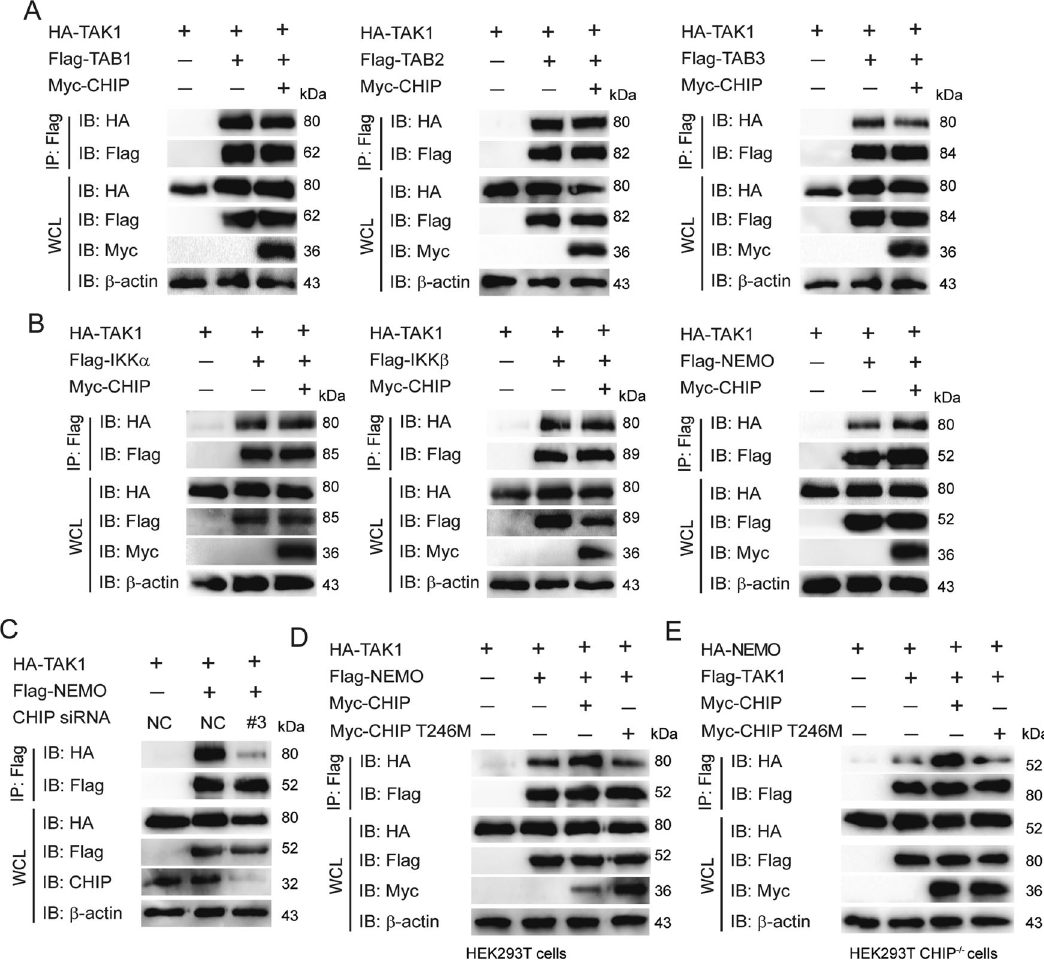
Fig. 5 CHIP potentiates the interaction between TAK1 and NEMO. A , B Overexpression of CHIP enhanced the interaction between TAK1 and NEMO. Immunoprecipitation and immunoblot analysis of HEK293T cells which were transfected with indicated plasmids as fi gures shown. C Knockdown of CHIP reduced the interaction between TAK1 and NEMO. HEK293T cells were transfected with HA-TAK1, Flag-NEMO, and an empty vector or CHIP-speci fi c siRNA. Whole cell extracts were immunoprecipitated with anti-Flag beads and blotted with anti-HA antibody. D , E The inactive mutant of CHIP could not enhance the interaction between TAK1 and NEMO. The indicated plasmids were transfected as fi gures shown in WT or CHIP − / − HEK293T cells, and the cell lysates were performed to immunoprecipitation and immunoblot analysis. All results were representative of three independent